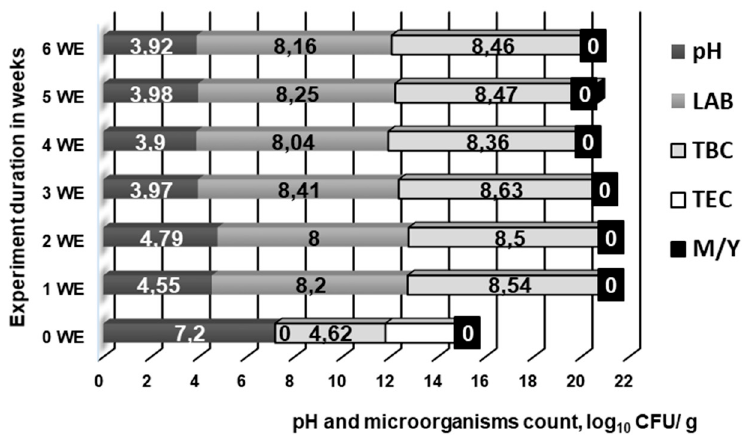
Figure 2. Microbial and pH changes during the feed fermentation process. The data are expressed as the mean ± standard deviation ( n = 3). The data were statistically compared with a paired t-test and column statistics; p ≤ 0.05 was considered significant. Abbreviation: CFU—colony-forming unit.